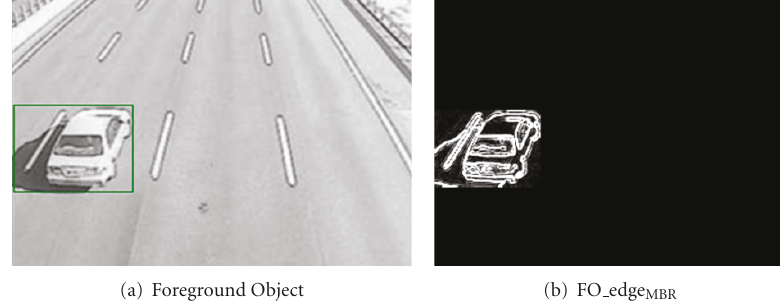
Figure 4: Sobel edge extraction from moving